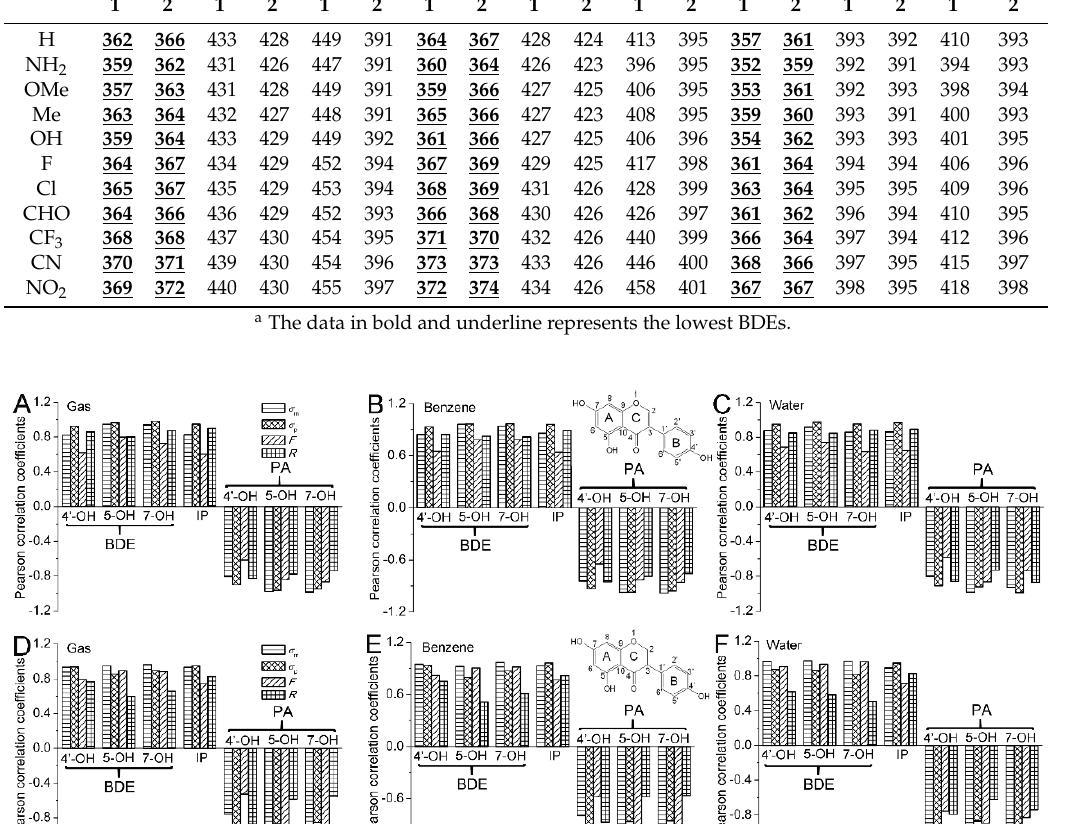
Figure 2. The Pearson correlation coefficients between the Hammett sigma constants ( σ m and σ p )/ F / R and the BDE/ ionization potential (IP)/ proton affinity (PA) in the gas, benzene, and water phases. For O − H in 4 (cid:48) ,5,7-trihydroxyisoflavone, the P ( BDE, σ p ) is larger than P ( BDE, σ m ) and exceeds 0.9. While for O − H in 4 (cid:48) ,5,7-trihydroxyisoflavanone, the P ( BDE, σ m ) is larger than P ( BDE, σ p ) and are